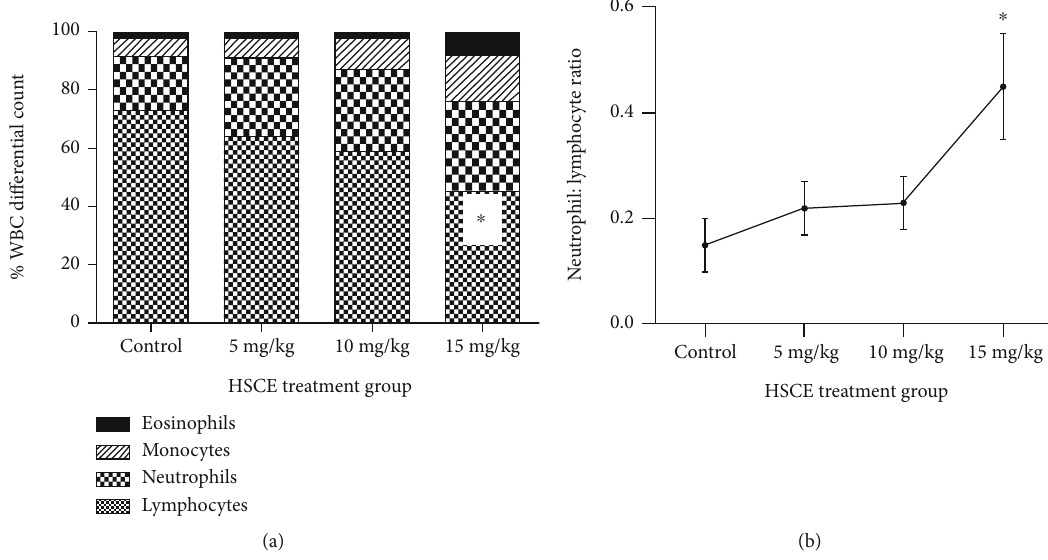
Figure 2: E ff ect of oral administration of the Haliclona ( Soestella ) sp. sponge crude extract (HSCE), once daily for 14 consecutive days in adult male Wistar rats: (a) di ff erential white blood cell counts (WBC/DC); (b) neutrophil :lymphocyte ratio. Results are expressed as mean ± SEM ( n = 6/group ). ∗ p < 0 : 05 (Mann-Whitney U test).